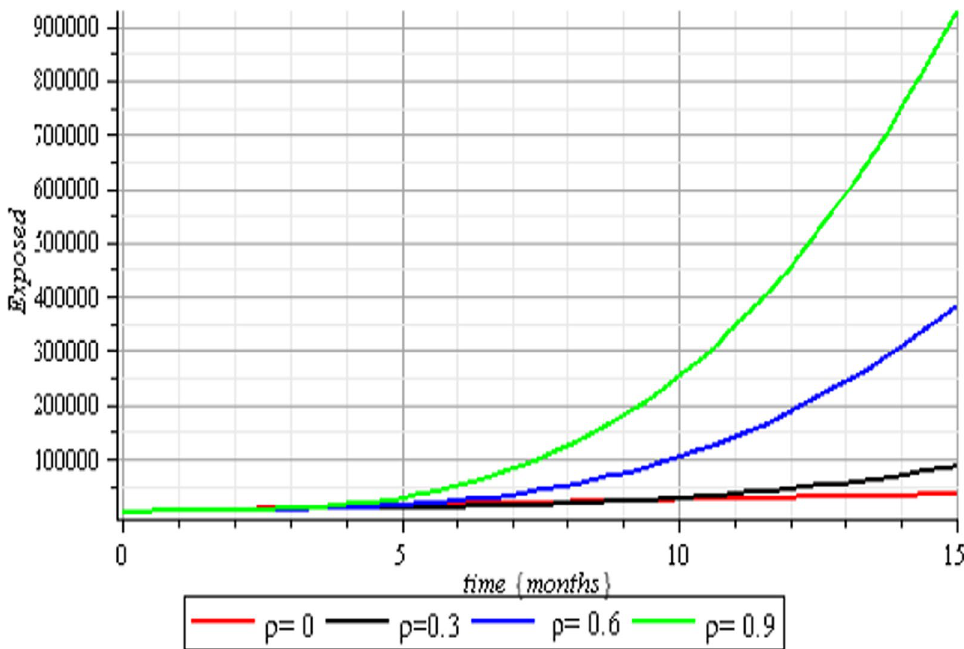
Fig. 8 Vaccination effects on the exposed class